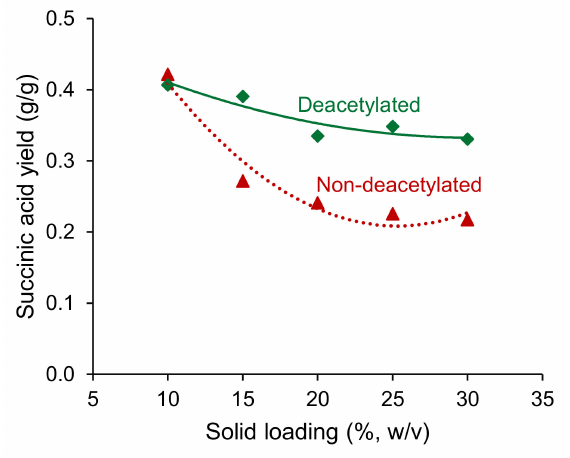
Figure 7. Succinic acid yield throughout 72 h fermentation from both deacetylated (solid lines) and non-deacetylated hydrolysates (dashed lines) at different oil palm trunk solid loadings. Table 2. Fermentation parameters of succinic acid production by A. succinogenes 130Z for 72 h using acid-pretreated oil palm trunk